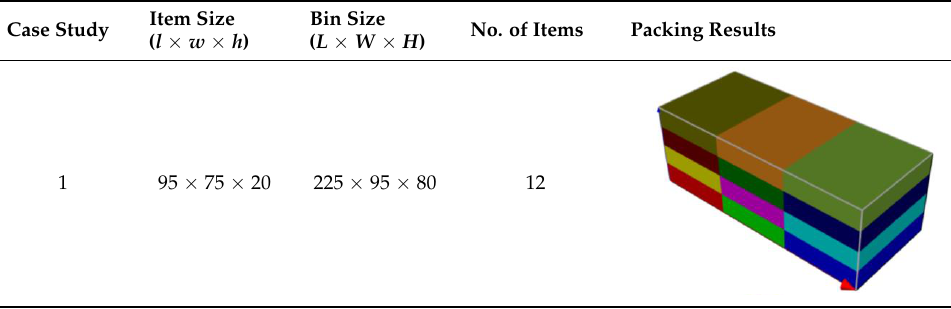
Table 9. The packing results for different bin sizes.